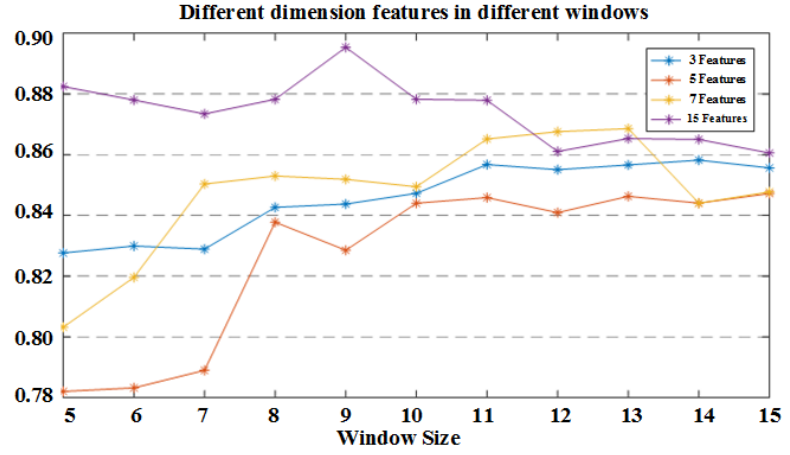
Figure 11. The recognition rate of different feature dimensions under different sliding windows.